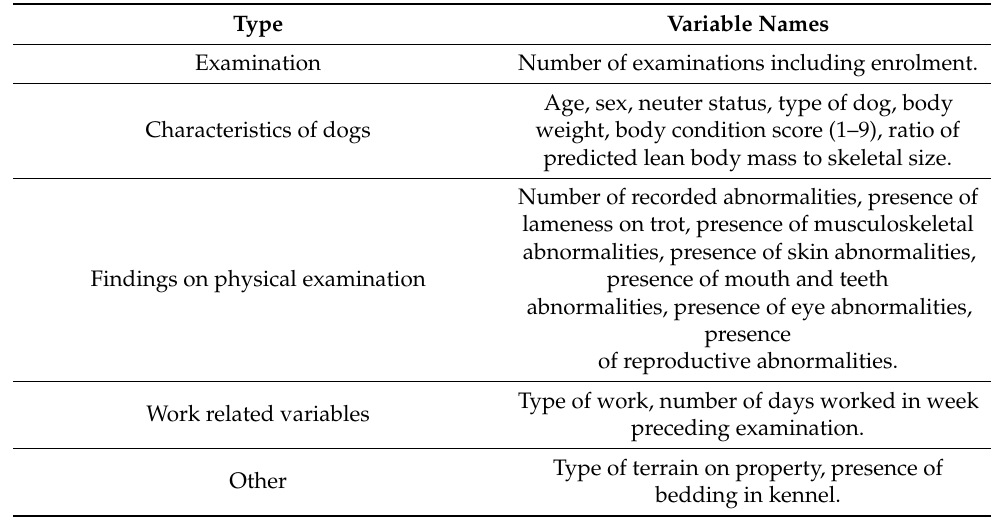
Table 1. List of explanatory variables that were assessed as possible risk factors for the death or retirement of working farm